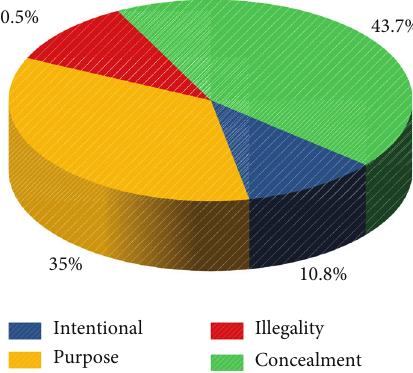
Figure 7: The proportion of various characteristics of listed